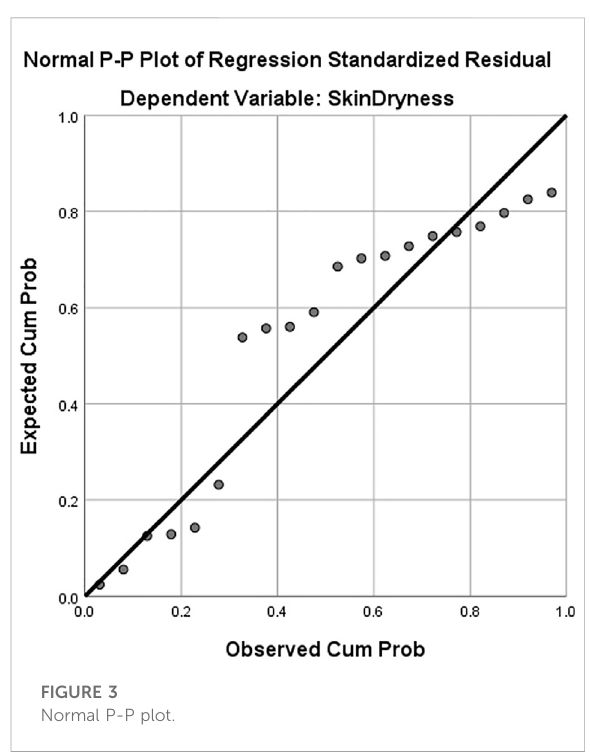
FIGURE 3 Normal P-P